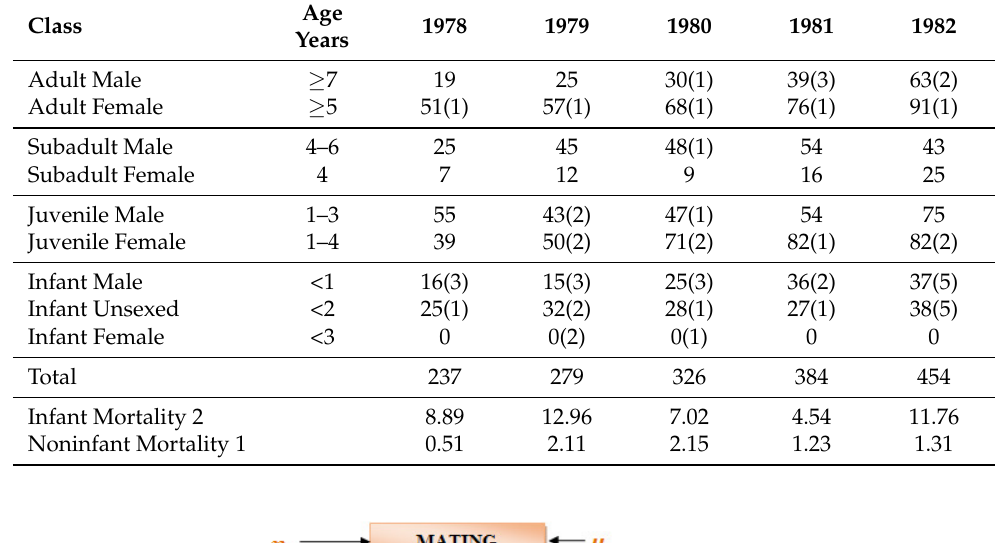
Table 1. Demographic composition of the monkey population (1978–1982).